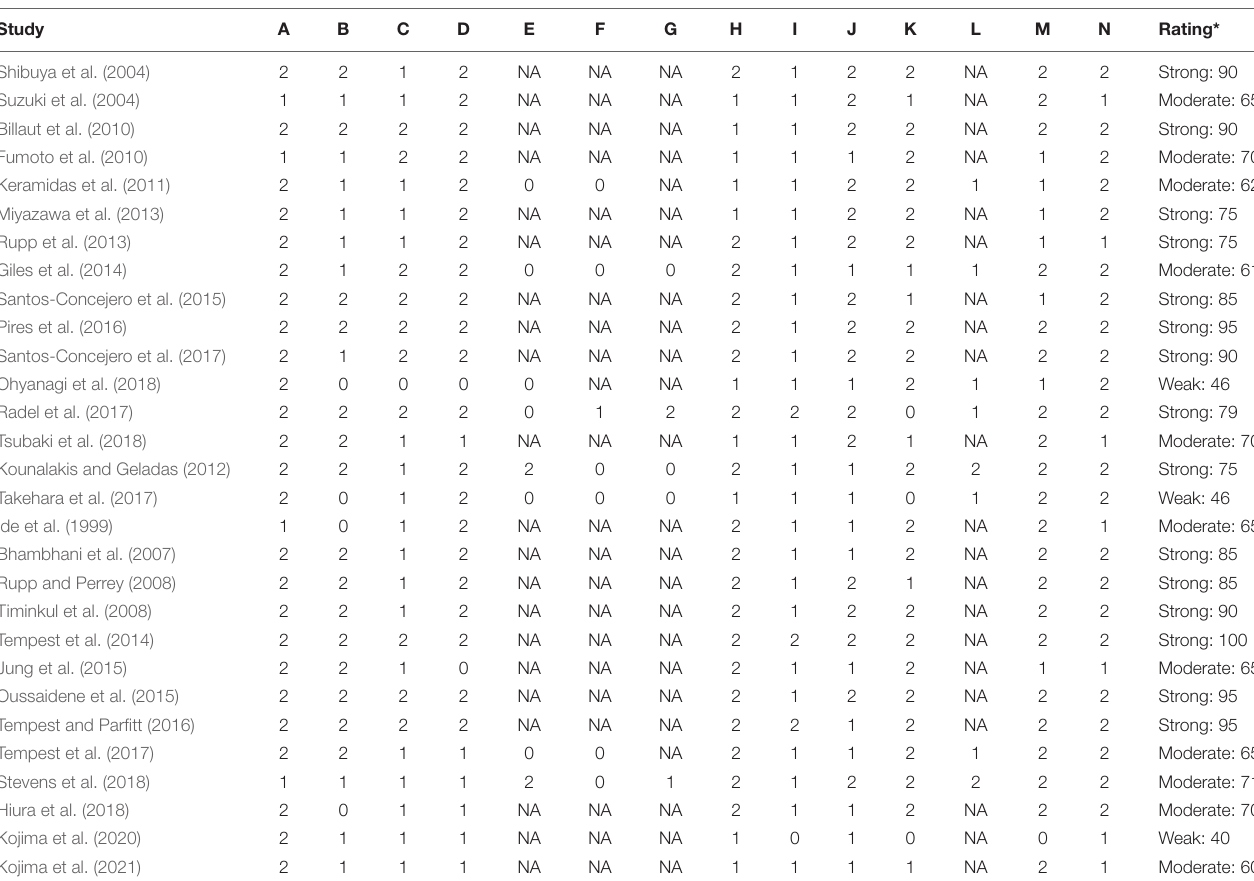
TABLE 4 | Quality assessment “QualSyst” (Kmet and Lee,